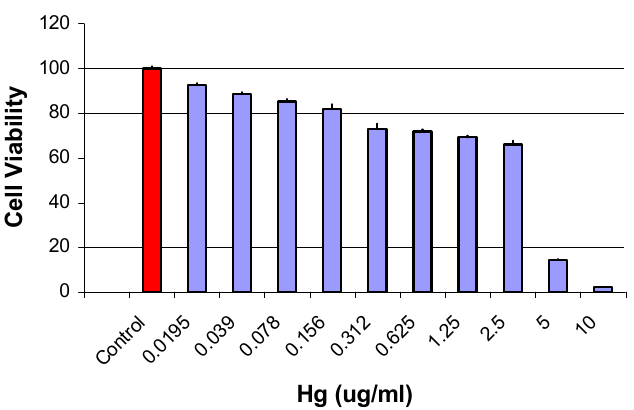
cells to mercury at 48 hours of exposure. Data represent means ± 2